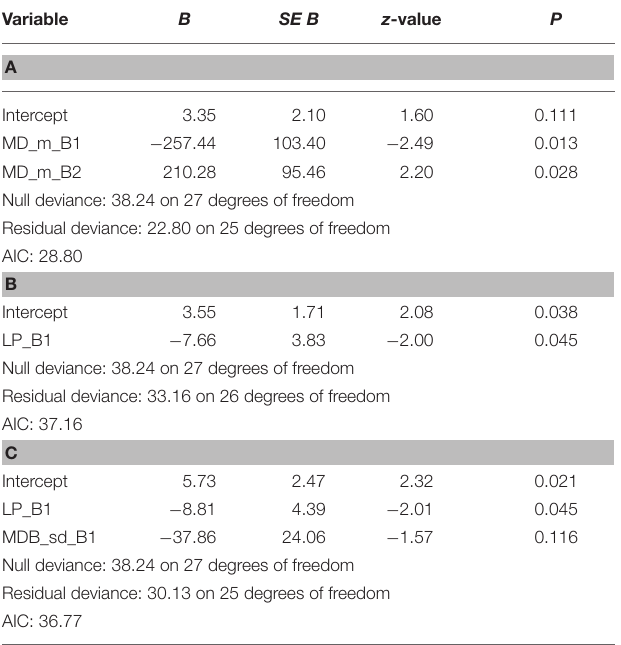
TABLE 2 | Summary of three binary regressions on (A) mean metrical deviation in section B1 (MD_m_B1) and the same in section B2